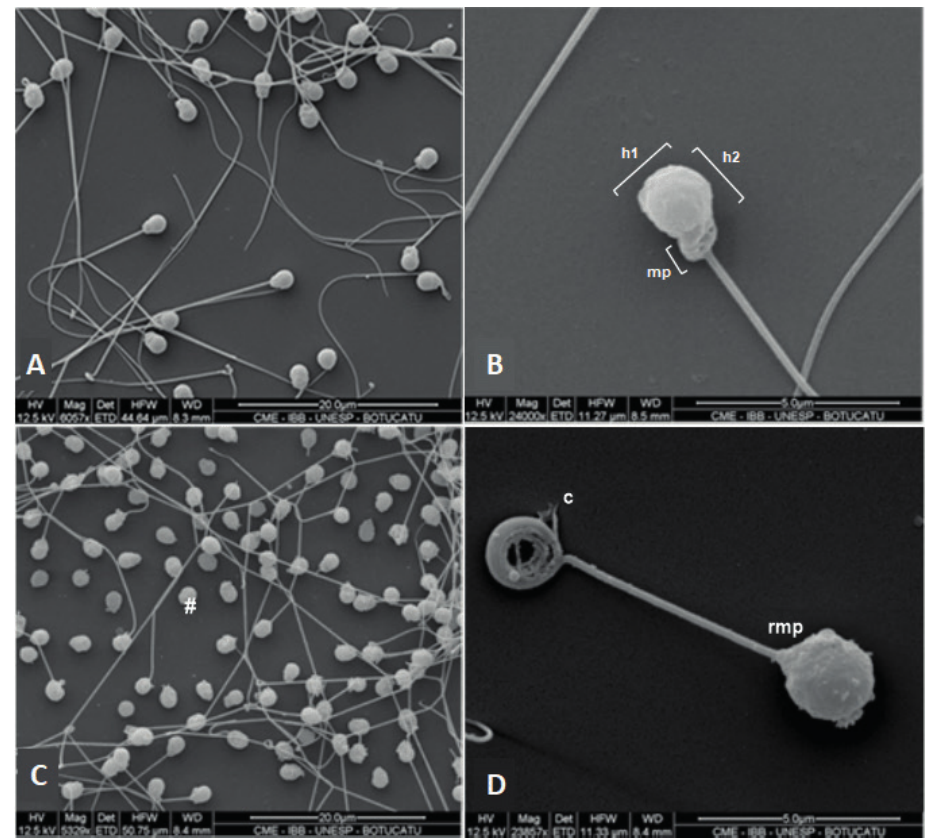
FIGURE 3 | Morphological characteristics of the Pseudoplatystoma corruscans sperm. A and B, normal spermatozoa; C and D, sperm with malformations. Legends: h1, width; h2, length; mp, intermediate part; #, sperm without the flagellum; c, curled tail; rmp, reduced middle piece. Scale bars; A and C = 20 µm; B and D = 5